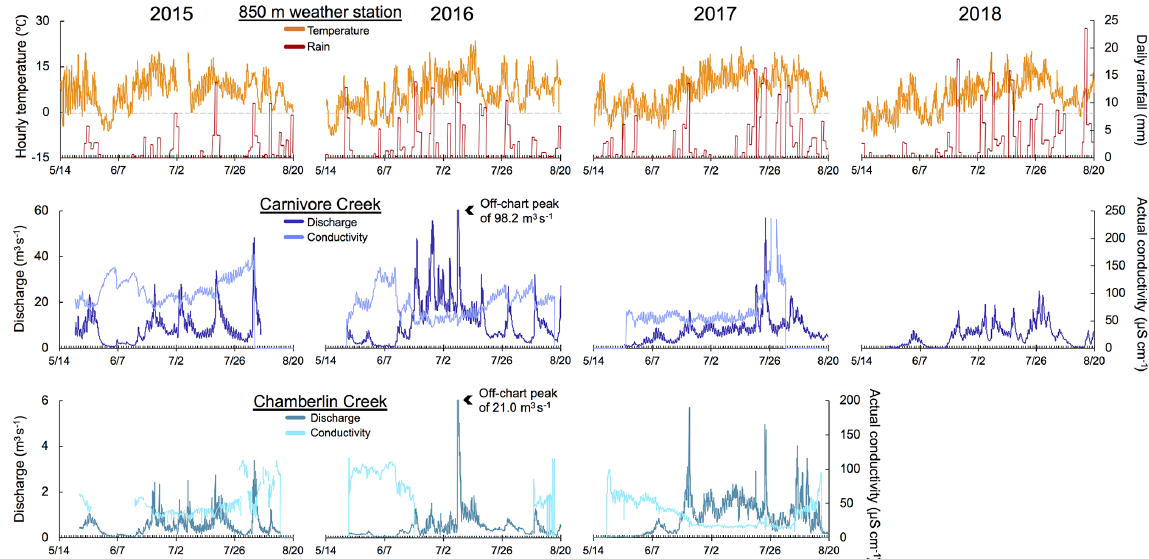
Figure 8. Time series of hourly air temperature and rainfall from the 850ma.s.l. weather station at Lake Peters shown alongside conductivity and discharge for Carnivore and Chamberlin creeks, 2015–2018. The gray line in the top row indicates 0 ◦ C.